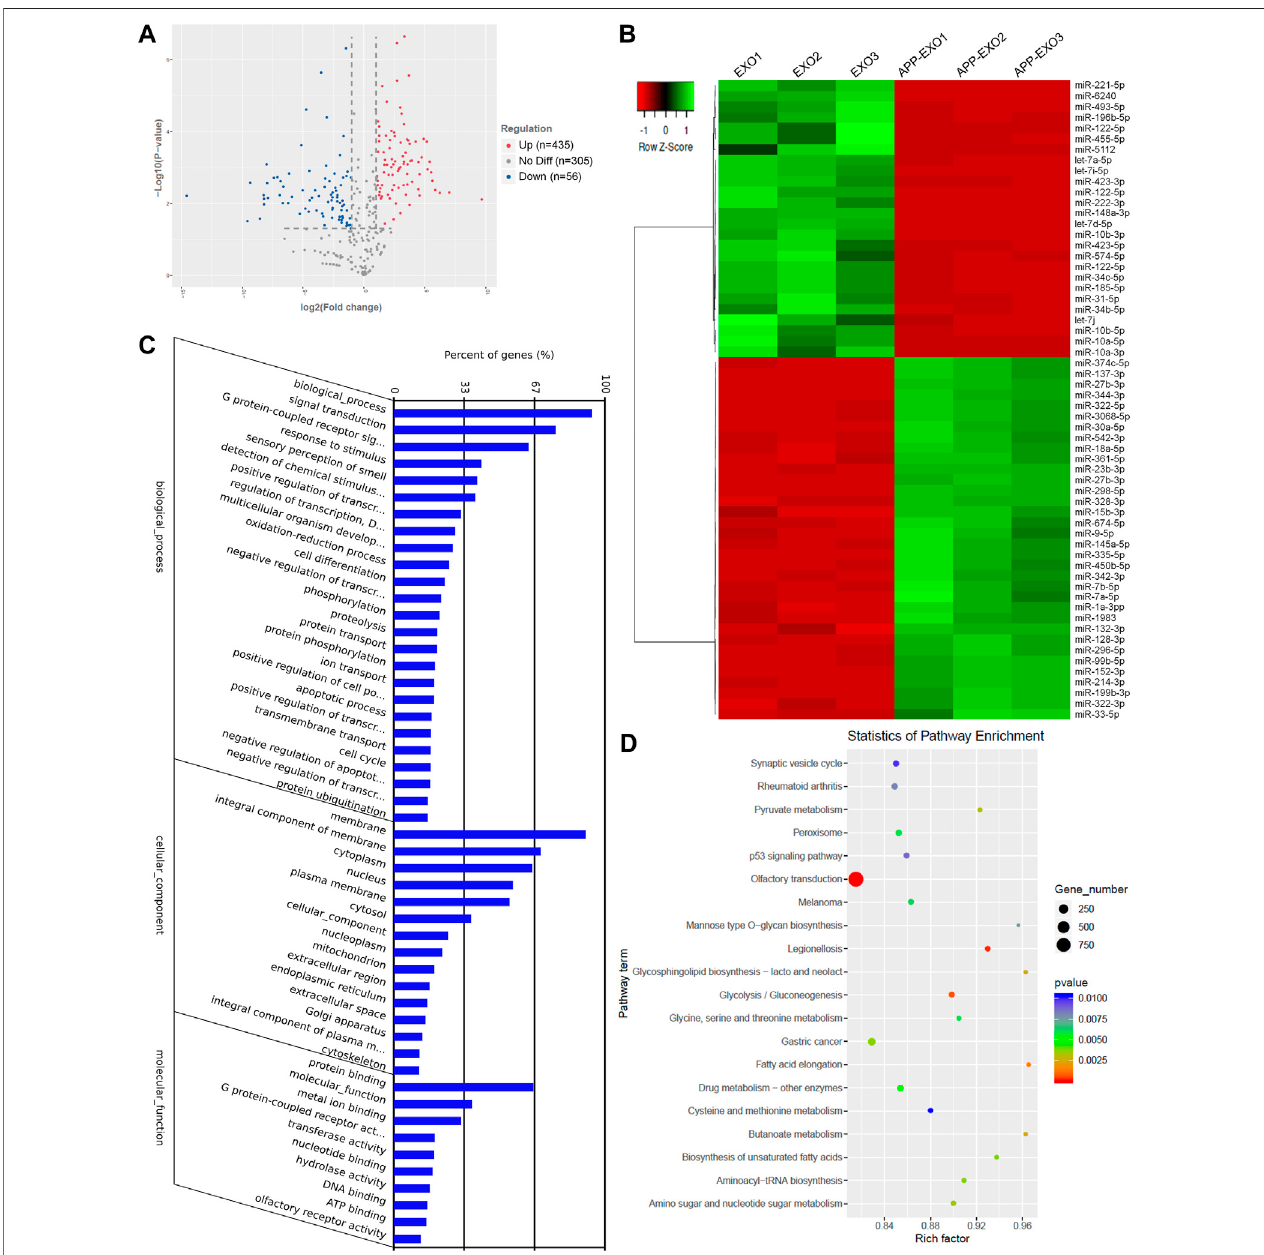
FIGURE 4 | APP overexpression signi fi cantly alters exosomal miRNA pro fi les. (A) The volcano plot was generated based on the logarithm of the p -values and the log fold change of all detected miRNAs in APP-EXO and EXO. (B) The top 60 differentially expressed miRNAs between APP-EXO and EXO are represented in the heat map and hierarchical clustering-based dendrograms. (C) The enriched gene ontology (GO) terms in the predicted targets of differentially expressed miRNAs were determined by GO analysis. (D) The enriched signaling pathways in the predicted targets of differentially expressed miRNAs were determined by KEGG analysis.